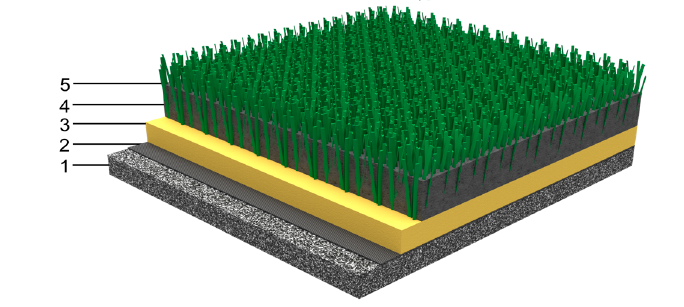
Figure 1. A 3G AT system. 1 Shockpad; 2 Carpet backing; 3 Sand infill; 4 Rubber infill; 5 Carpet fibers.